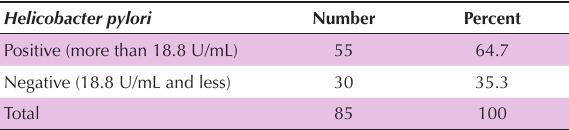
Table 3. Frequency distribution and percentage of positive and negative results of Helicobacter pylori antibody